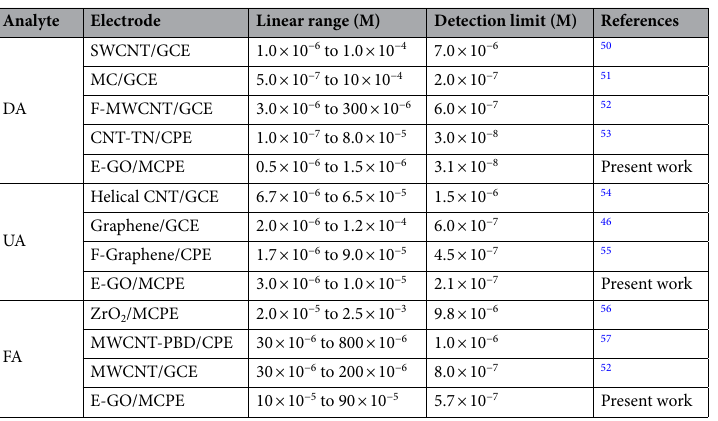
Analyte Electrode Linear range (M) Detection limit (M) References